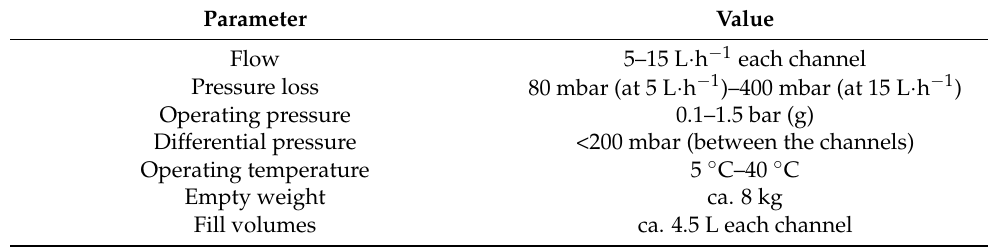
Table 12. Spiral-wound module characteristics. Parameters were downloaded from the online module datasheet